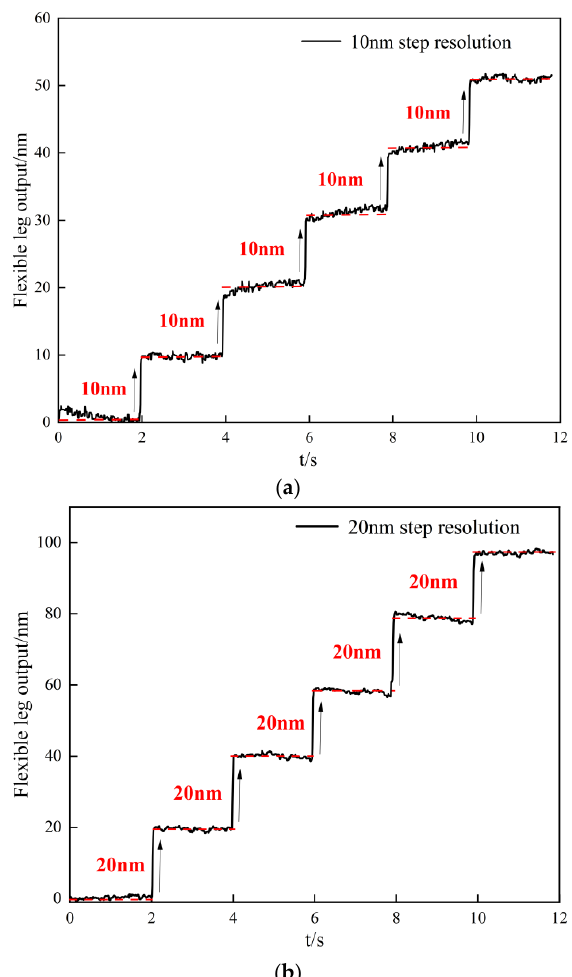
Figure 10. ( a ) Output resolution of the flexible leg with open-loop 5 mV voltage input ( b ) Output resolution of the flexible leg with SGS-closed-loop 5 nm displacement input.